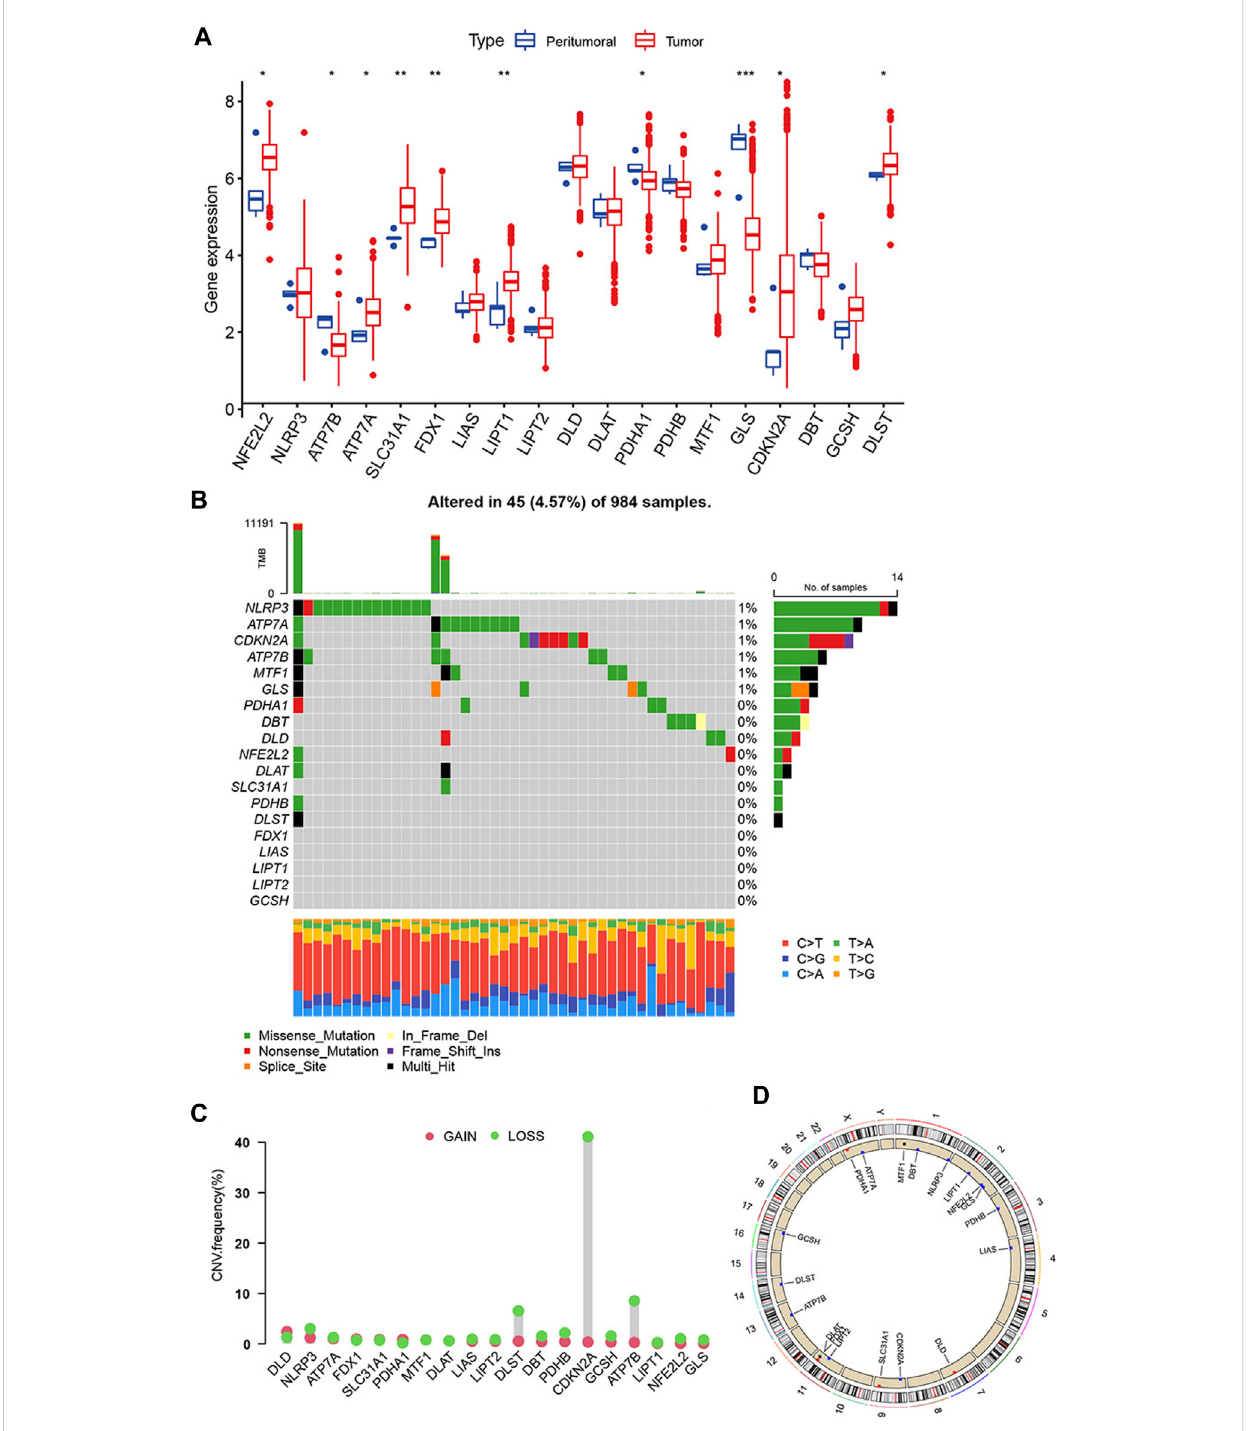
FIGURE 1 Genetic alterations of cuproptosis-related genes in glioma. (A) Expression of 19 cuproptosis-related genes in glioma and adjacent tissue. (B) Mutations of 19 cuproptosis-related genes in a cohort of 984 glioma patients ’ samples. (C) CNVs frequencies of cuproptosis-related genes. (D) Location of cuproptosis-related genes on chromosomes and their CNV alterations. (* p < 0.05; ** p < 0.01; *** p <